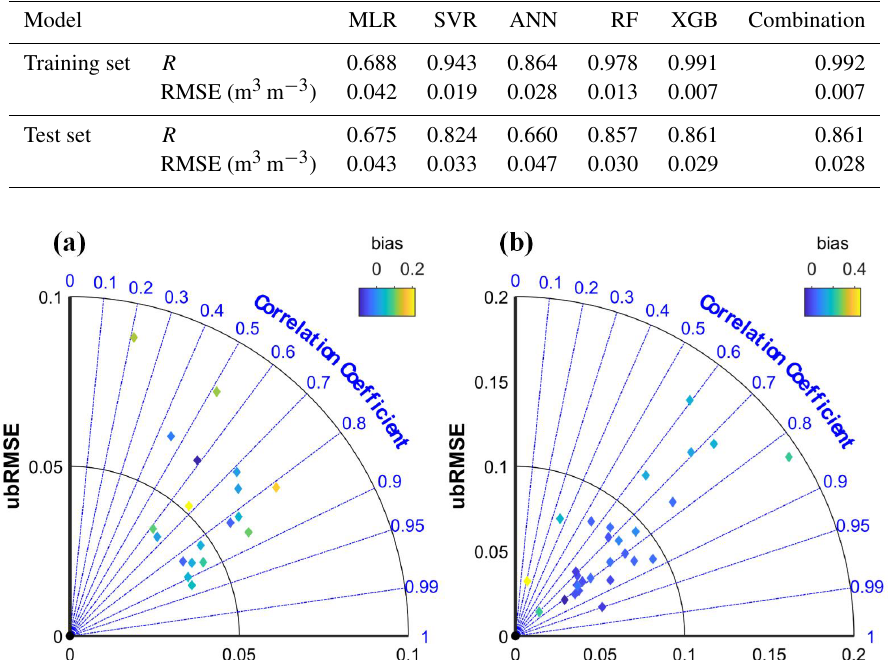
7 shows the results of the 19 sites of the Maqu network. All four statistical metrics, namely R , RMSE, ubRMSE and